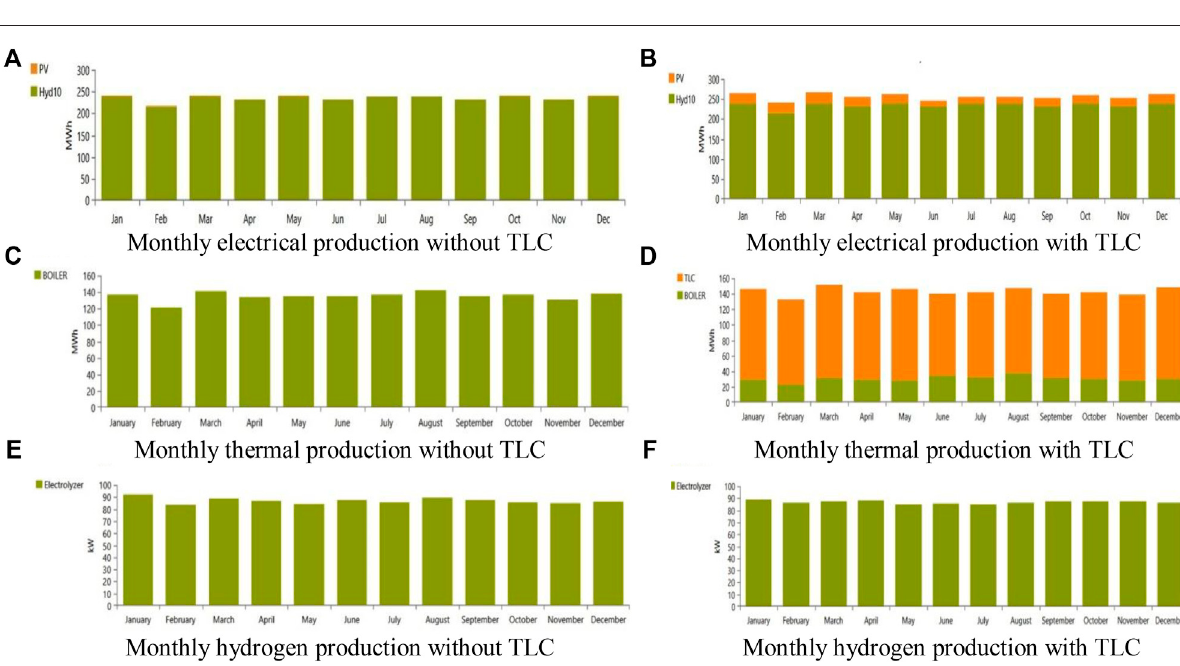
FIGURE8| Monthlyenergyproductions. (A) MonthlyelectricalproductionwithoutTLC. (B) MonthlyelectricalproductionwithTLC. (C) Monthlythermalproduction without TLC. (D) Monthly thermal production with TLC. (E) Monthly hydrogen production without TLC. (F) Monthly hydrogen production with TLC.